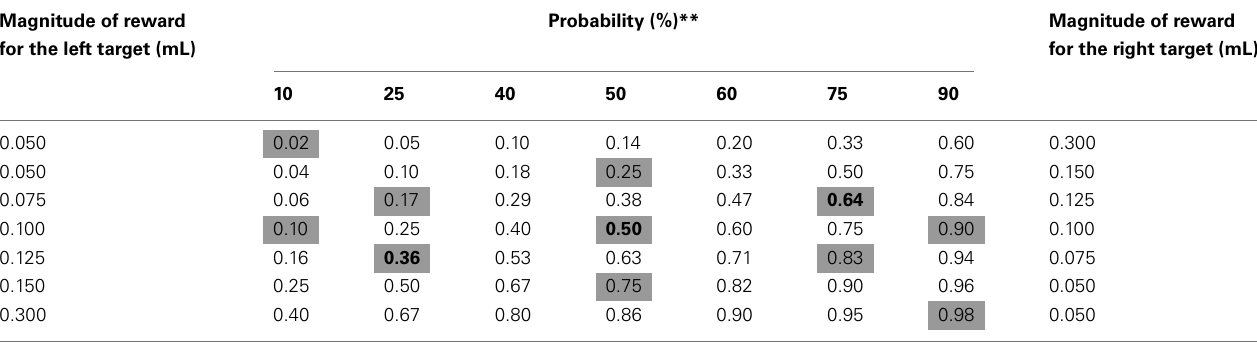
Probability (%)** Magnitude of reward